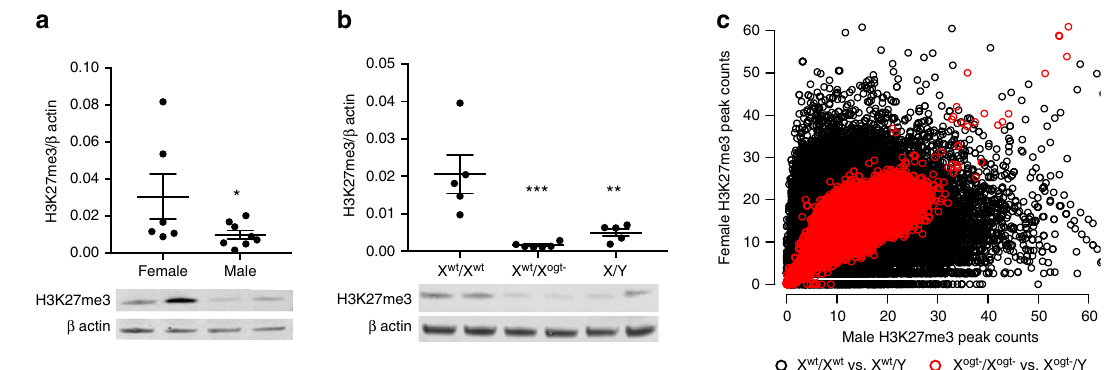
Fig. 3 OGT regulates placental H3K27me3 levels. a Western immunoblot quanti fi cation of H3K27me3 in human term placenta ( t -test, t (12) = 1.896, p = 0.0412, n = 6 female, n = 8 male). b This sex difference was also present in E12.5 mouse placenta and was eliminated by placental Ogt reduction in female trophoblasts, X ogt − /X wt (ANOVA, F (2,13) = 12.9, p = 0.0008, n = 5 X wt /X wt , X wt /Y, n = 6 X ogt − /X wt from 10 litters with n = 1/group/litter). c Scatterplot of ChIP-Seq H3K27me3 peak counts within 2 Kb of transcription start sites showing widespread sex differences (black circles) were greatly reduced by trophoblast-speci fi c Ogt deletion in both sexes (red circles; n = 3 X wt /X wt , n = 4 X wt /Y, X ogt − /X ogt − & X ogt − /Y from 8 litters with n = 1/group/litter). * p < 0.05 compared to X wt /X wt . Bars represent mean ± shared predictable expression patterns in the hypothalamus of